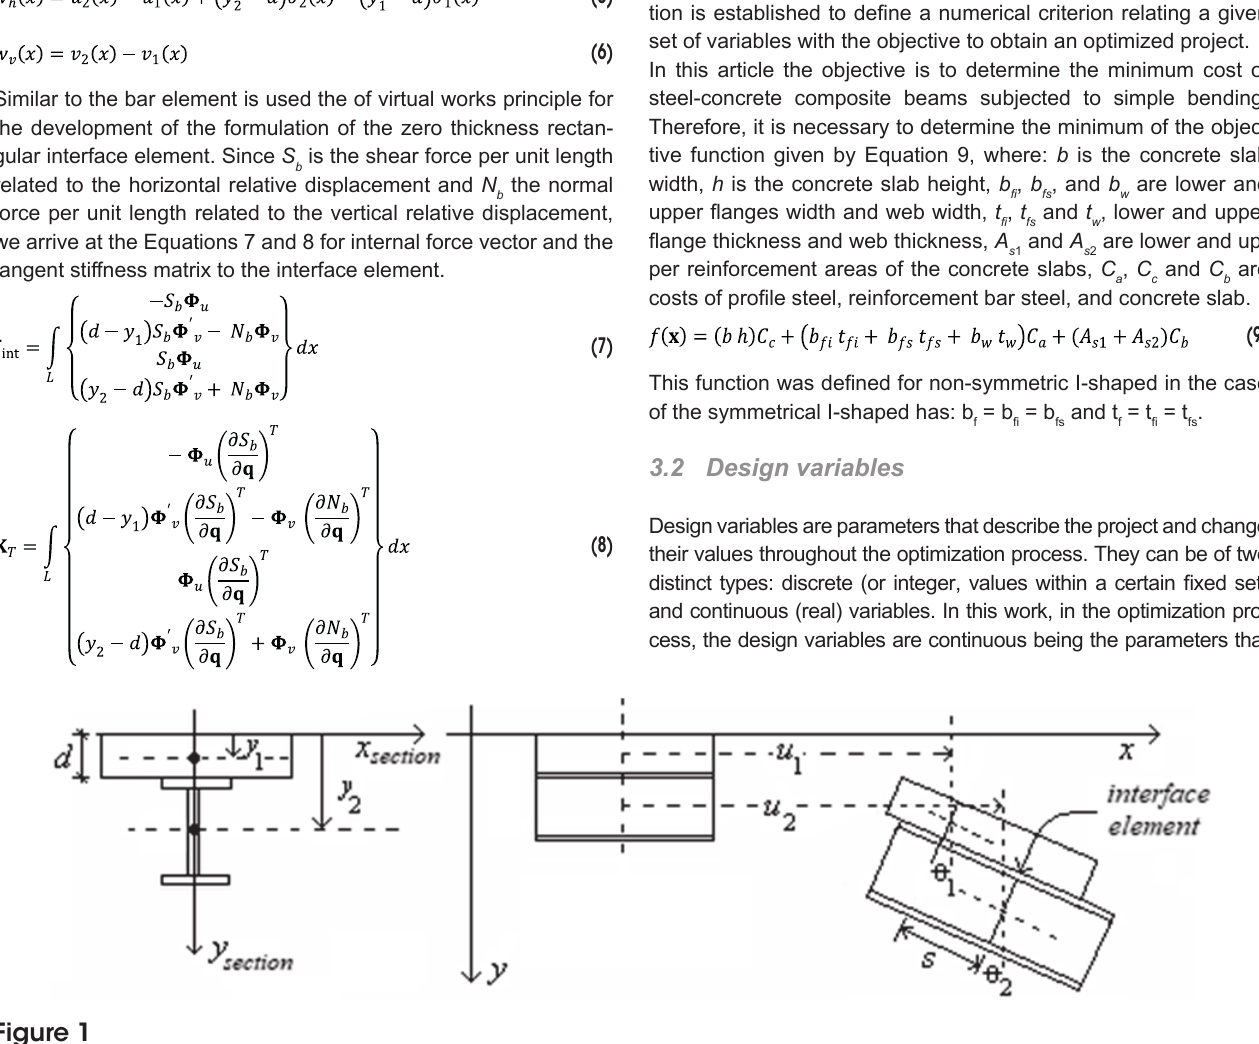
Deformation of a composite beam segment